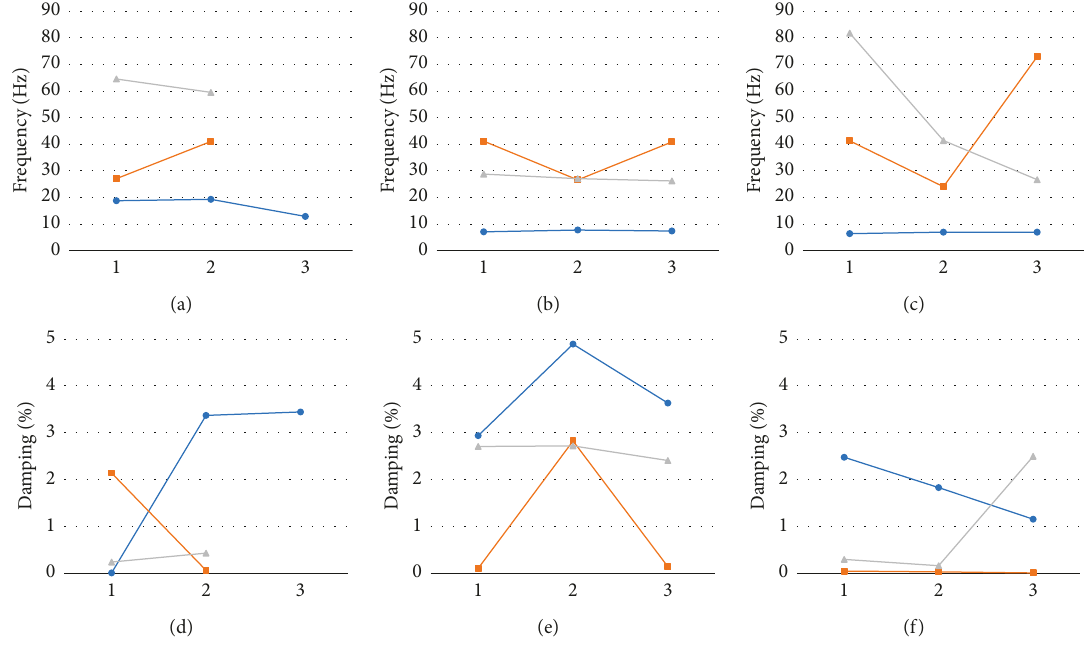
Figure 10: 1st torsional modal shape: comparison of dynamic